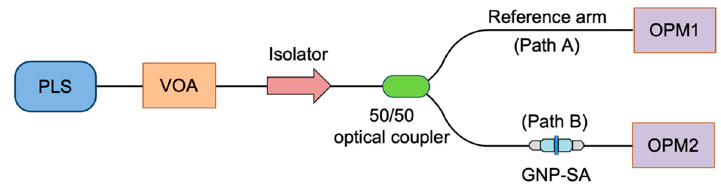
Figure 4. Nonlinear saturable absorbance of SA measurement setup.